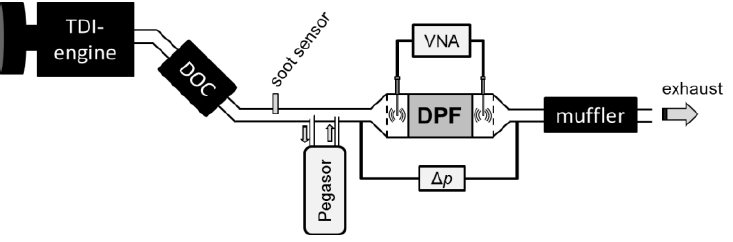
Figure 1. Experimental setup for the dynamometer tests with the different measuring devices: resistive soot sensor and Pegasor sensing device to measure the soot concentration of the raw exhaust, the vector analyzer VNA to obtain the transmission parameter | S 21 | in the microwave range between 0.9 and 2.1 GHz and the differential pressure sensor (Δ p ) for soot load determination. Furthermore, the filter is weighed from time to time.